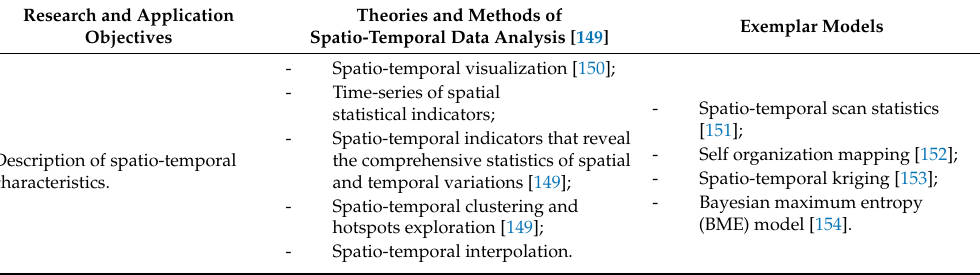
Table 4. Summary of theories and methods of spatio-temporal data analysis.